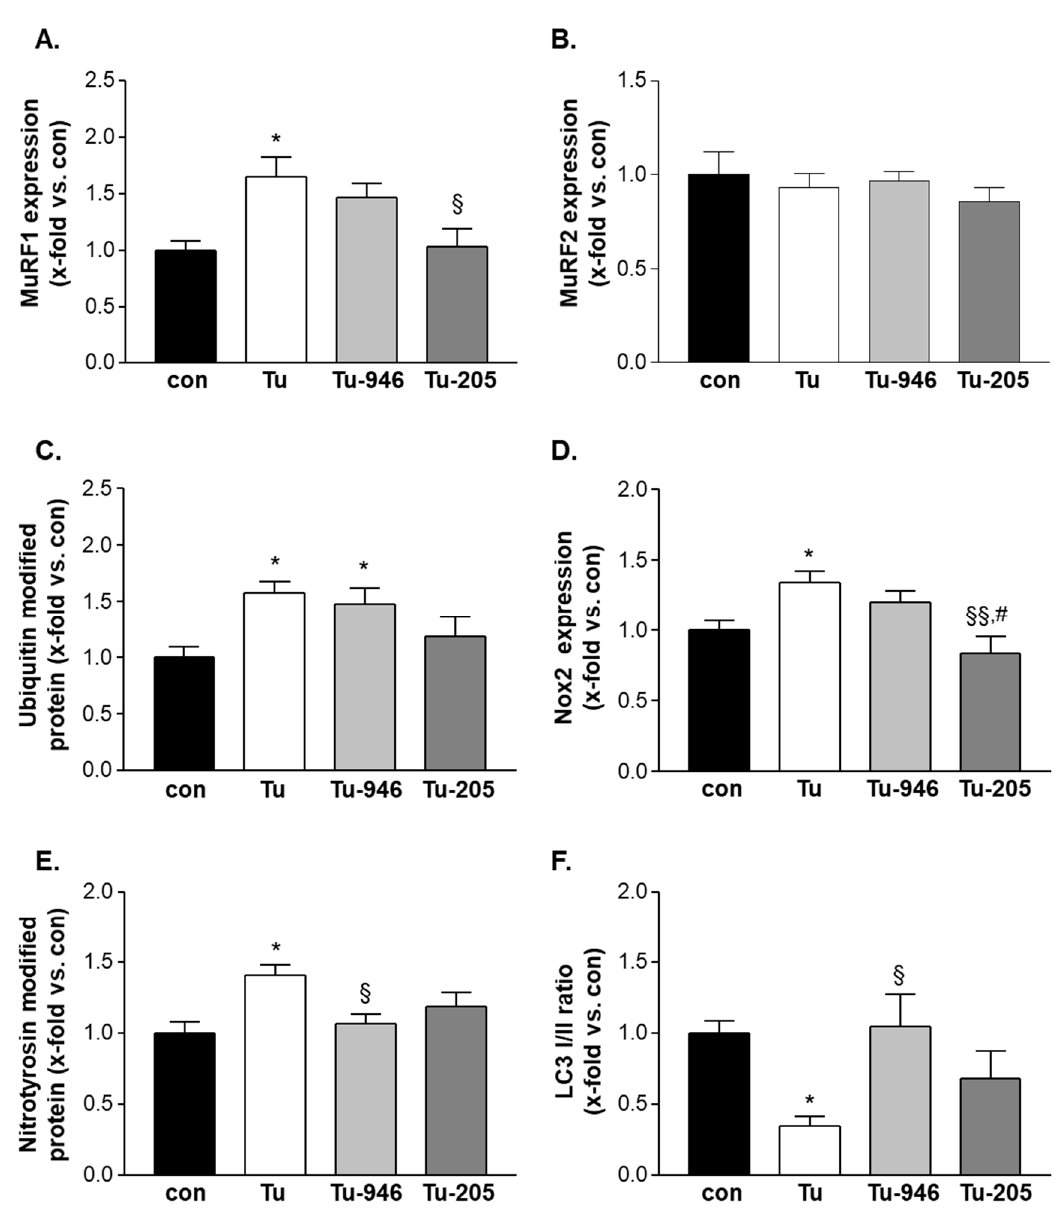
Figure 5. Western blot analysis were performed in the EDL muscle in all groups using specific antibodies against MuRF1 ( A ), MuRF2 ( B ), ubiquitin modified proteins ( C ), Nox2 ( D ), nitrotyrosin modified proteins (E) and LC3 (F). Values are shown as mean ± standard error of the mean. * p < 0.05 vs. con; § p < 0.05, §§ p < 0.01 vs. Tu; # p < 0.05 vs Tu-946.